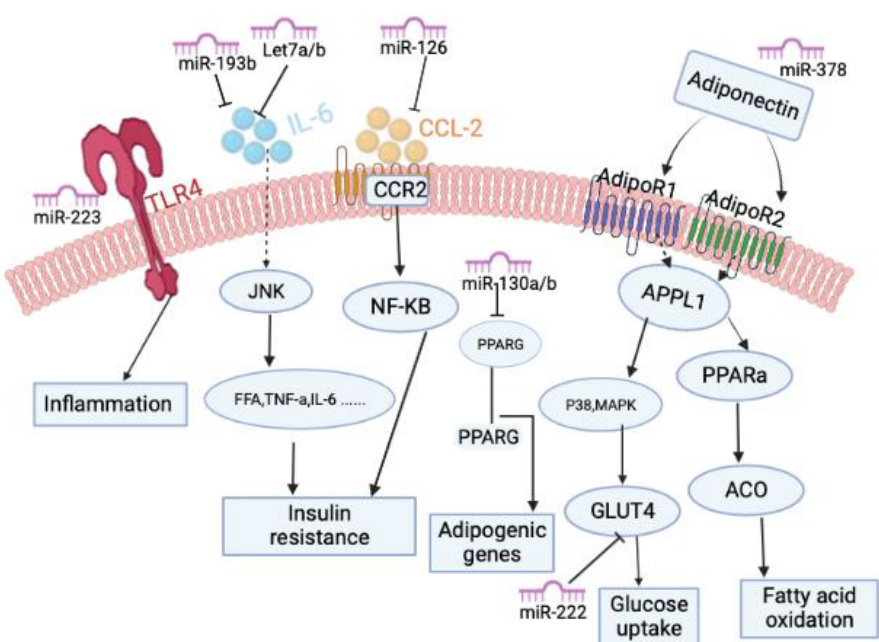
Figure 2. Molecular pathway of miRNAs as therapeutic targets for obesity. MicroRNAs can affect obesity-related signaling pathways by regulating the activation of transcription factors and cellular proteins.